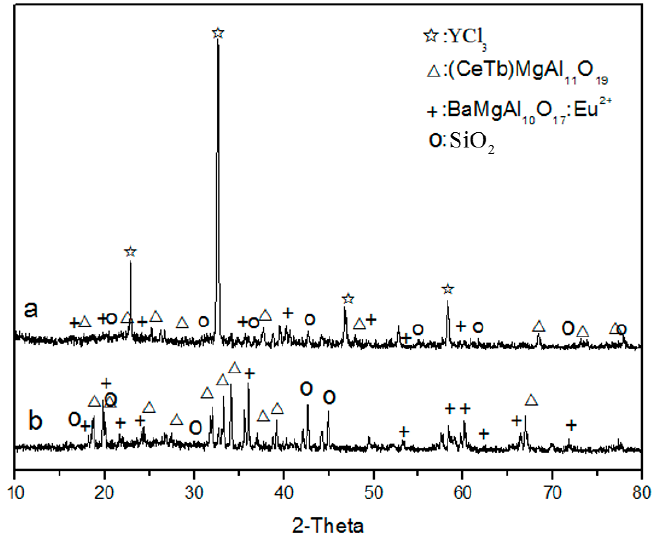
Figure 8. XRD analysis of waste phosphor after roasting ( a ); and water leaching ( b ).